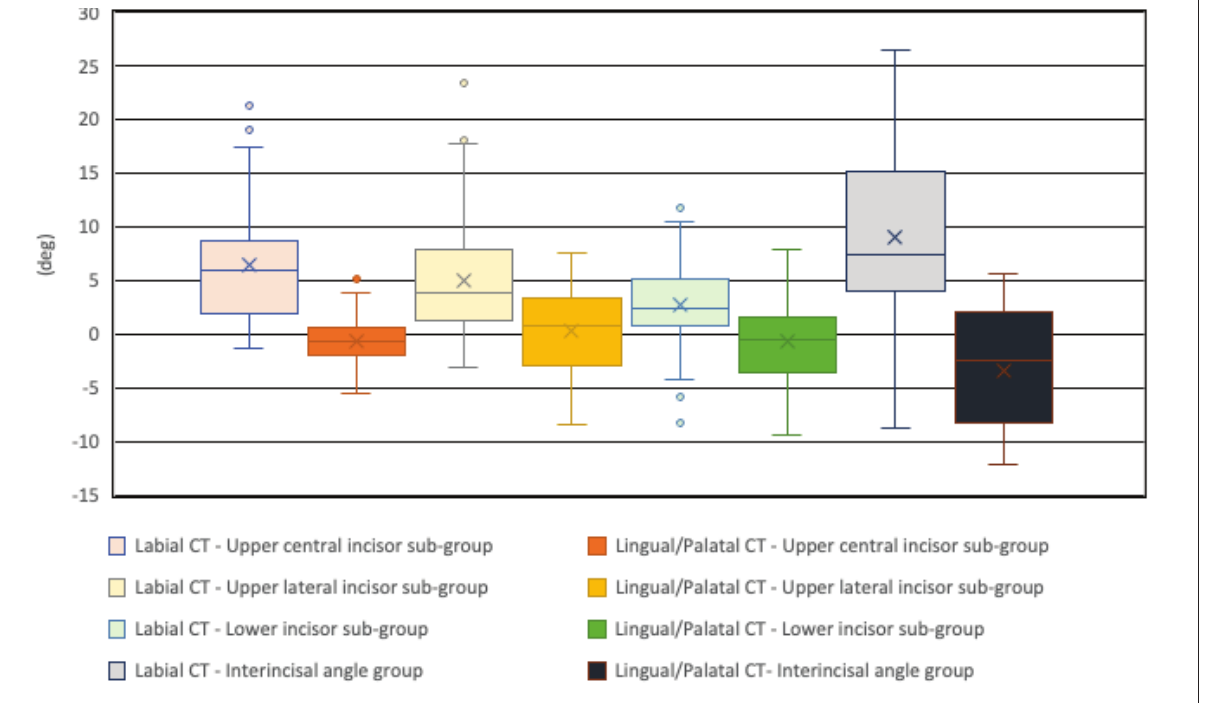
Figure 7. Box-whisker plot showing the distribution of torque and IIA